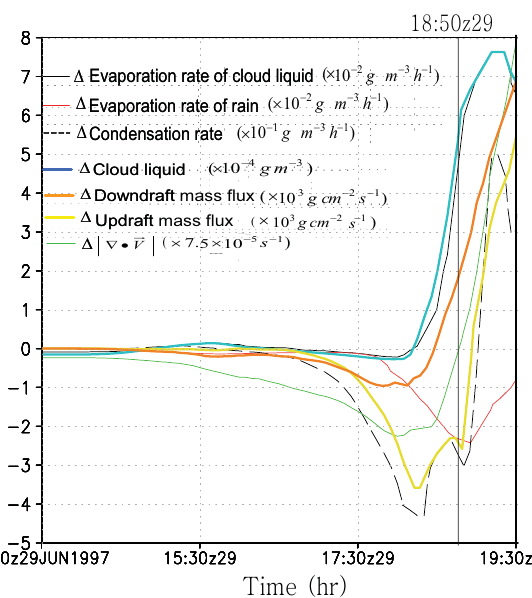
Fig. 6. Time series of difference (High – Low) in domain-averaged evaporation rate of cloud liquid and rain ( × 10 − 2 gm − 3 h − 1 ) , condensation rate ( × 10 − 1 gm − 3 h − 1 ) , cloud liquid mass con- centration ( × 10 − 4 gm − 3 ) , updraft, downdraft mass fluxes (cid:12) (cid:12) −→ (cid:12) (cid:12) ∇ • × 7.5 × 10 − 5 s − 1 ) from the be- V ( × 10 3 gcm − 2 s − 1 ) , and (cid:12) (cid:12) ( ginning of time integration to 19:30 GMT 29 June. Downdraft mass (cid:12) (cid:12) −→ (cid:12) (cid:12) ∇ • V flux and (cid:12) (cid:12) are averaged over the lowest